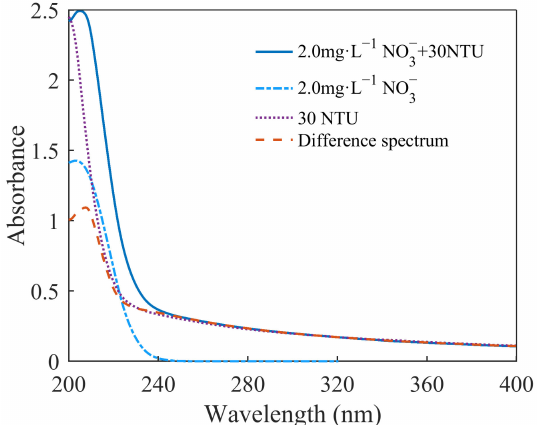
Figure 8. Spectra of the mixed solution, the nitrate solution, the turbidity solution, and their differ- ence